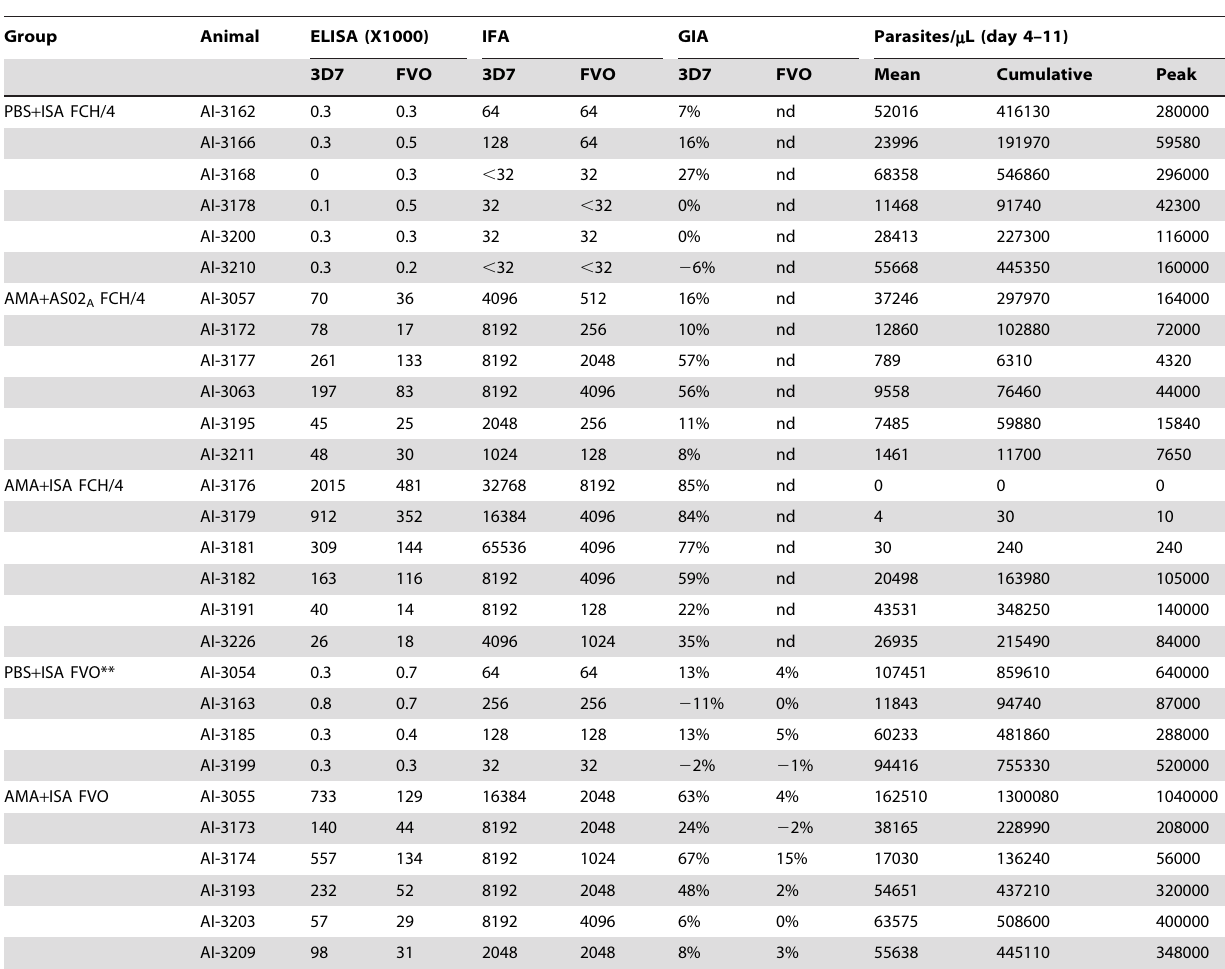
Table 1. Immunogenicity and efficacy data of individual animals.